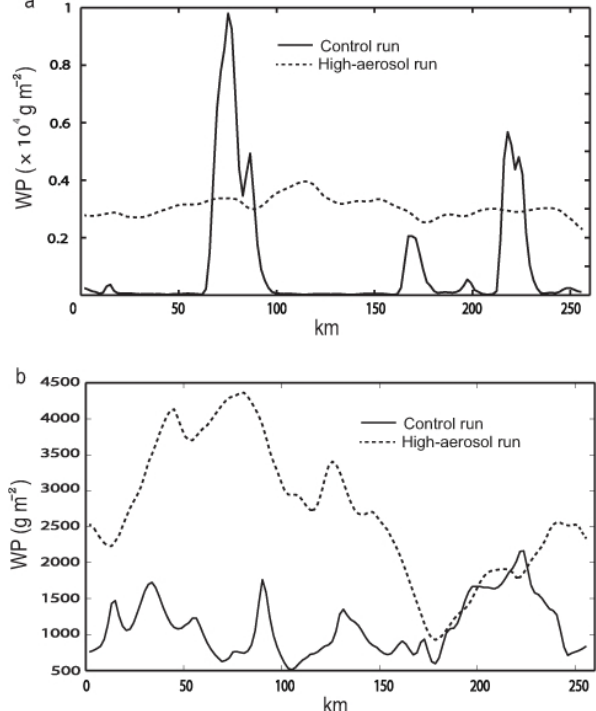
Fig. 7. Spatial distribution of WP over the horizontal domain (a) at the time of maximum difference around 03:00LST on 24 January in the WP homogeneity and (b) at the time of minimum difference in the WP homogeneity around 12:00LST on 24